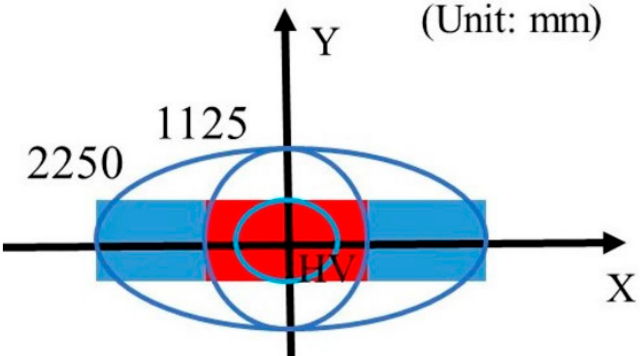
Figure 8. Test points and regions of the high beam. The traditional design uses an ellipsoidal reflector to focus the rays emitted from the source, while part of the rays emitted from the high beam source will be blocked by the low beam source due to the volume of the LED source. It will cause significant energy losses, as shown in Figure 9a. Therefore, the construction in Figure 1 is adopted to improve light efficiency and illumination. Rays emitted from the high beam source focus on a point on Z axis by the freeform surface reflector, as shown in Figure 9b.